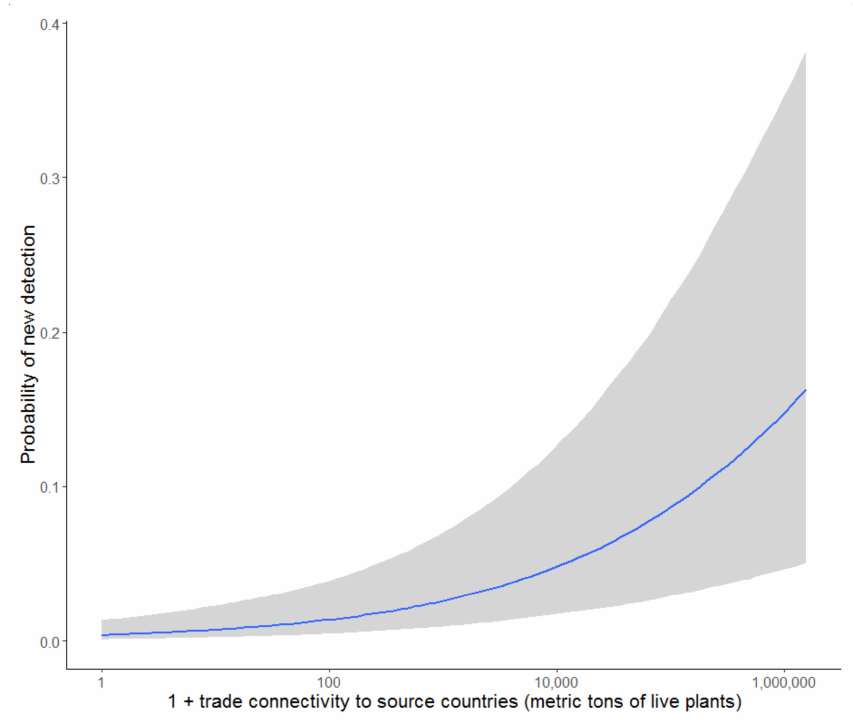
Figure 8. Estimated relationship between Phytophthora arrival risk and imports of live plants from potential source regions, conditional on climate matching, national pest and pathogen reporting and biosecurity capacity. Grey shading represents 95% confidence intervals based on the fixed effects, excluding variance among species due to random effects.